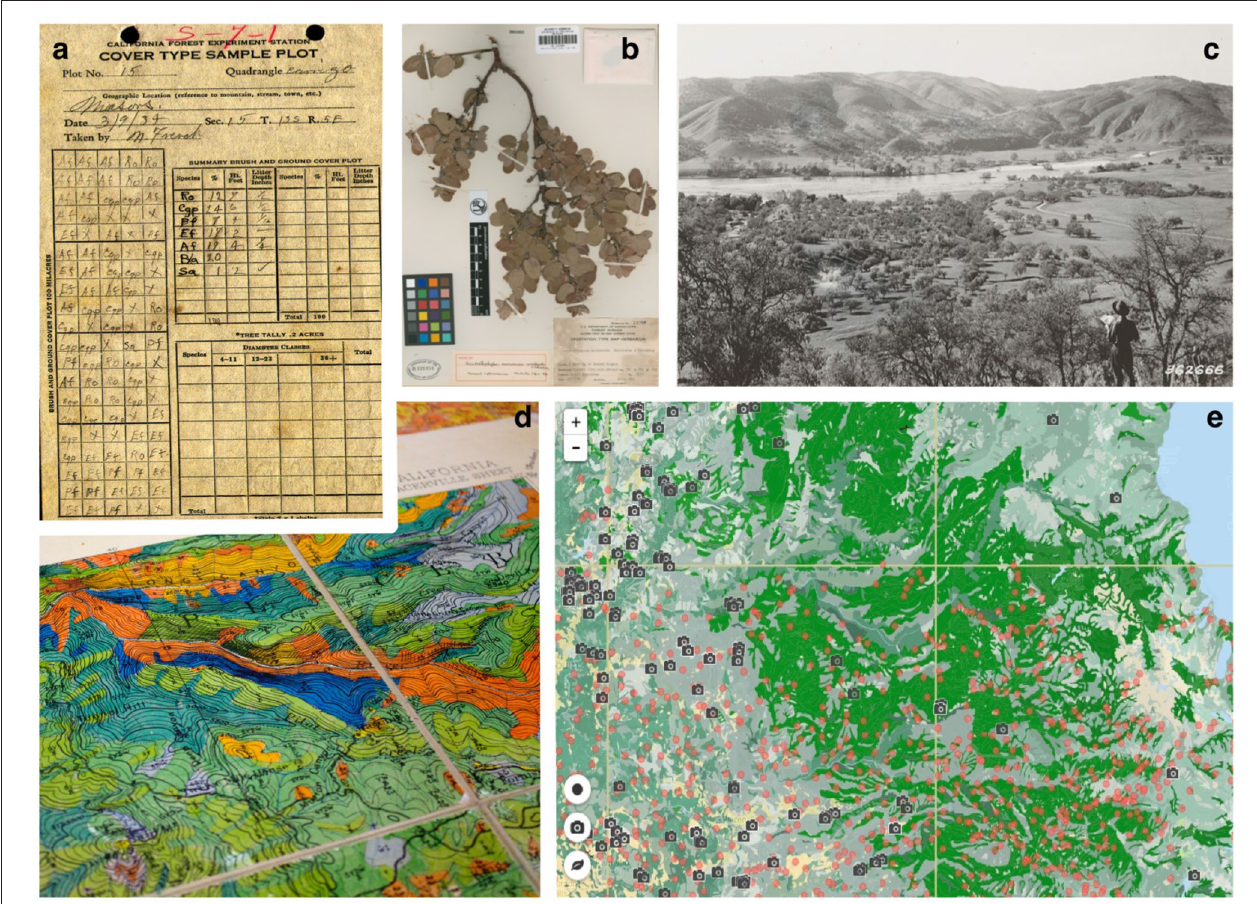
FIGURE 4 | Examples of the components of the VTM collection: (a) plot card recording floristic species; (b) herbarium specimen ( Arctostaphylos morroensis , San Luis Obispo Co.); (c) a landscape photograph San Antonio River, Monterey Co. 1938; (d) vegetation type map (Placer Co.); and (e) the digital representation (vtm.berkeley.edu) of maps, plots, and photographs, showing part of Lake Tahoe. In (e) the background colors represent different vegetation types, red dots are plot locations, and black icons are photograph